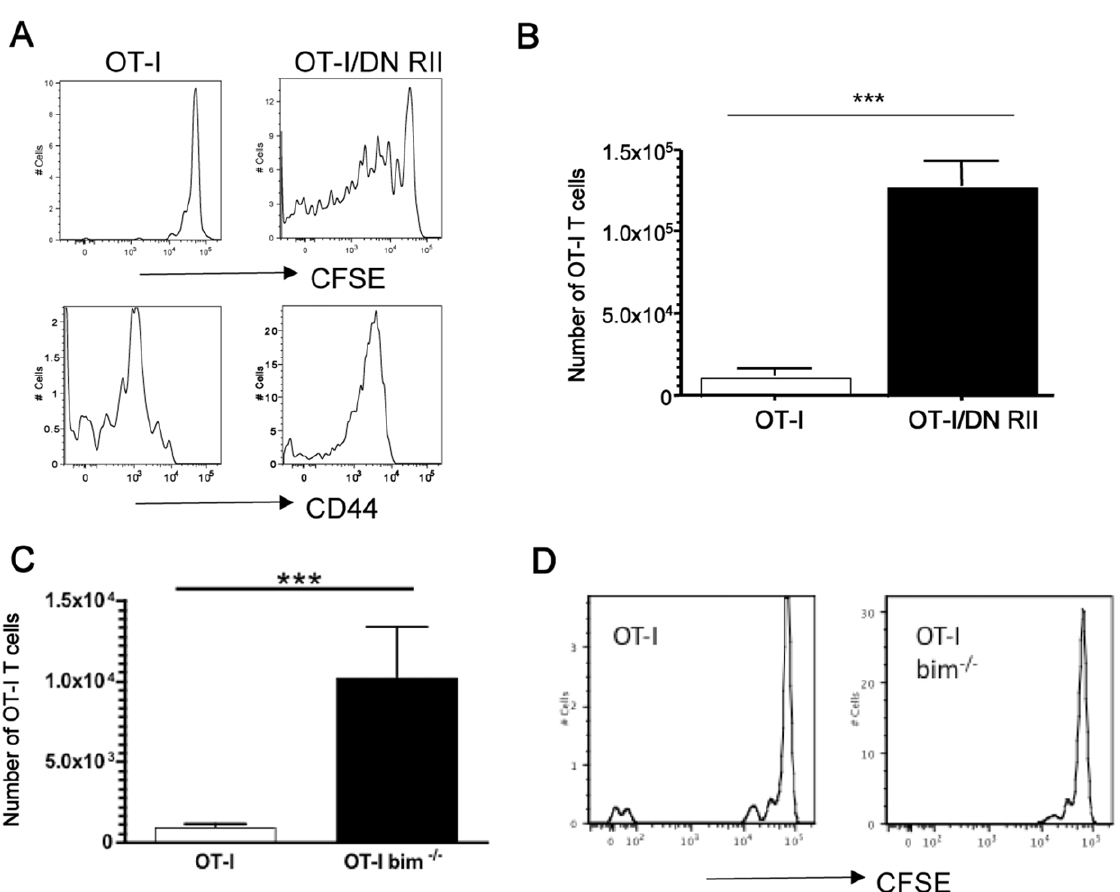
Figure 4. OT-I/DNRII homeostatically proliferate in the absence of both IL-7 and IL-15. ( A,B ) CFSE labeled CD44 lo OT-I Rag 2 / 2 or OT-I/ DNRII Rag 2 / 2 CD8 T cells were transferred into sublethally irradiated IL-7 2 / 2 x IL-15 2 / 2 hosts. After 1 week, spleens were harvested from sacrificed mice and donor cells were analyzed. ( A ) shows representative CFSE dilution and CD44 expression histograms for OT-I and OT-I/DNRII CD8 T cells, as indicated and ( B ) shows recovery of OT-I and OT-I/DNRII 1 week after transfer in the spleen (n=3 per group). Results in (A,B) are representative of at least 3 independent experiments. ( C,D ) CFSE labeled CD44 lo OT-I or OT-I Bim 2 / 2 CD8 T cells were transferred into sublethally irradiated IL-7 2 / 2 x IL- 15 2 / 2 hosts and donor cells analyzed in the spleen 1 week later. (C) shows recovery of donor OT-I and Bim 2 / 2 OT-I CD8 T cells (n=5), while (D) shows representative CFSE dilution histograms for these populations. The data in (C,D) are derived from two independent experiments.